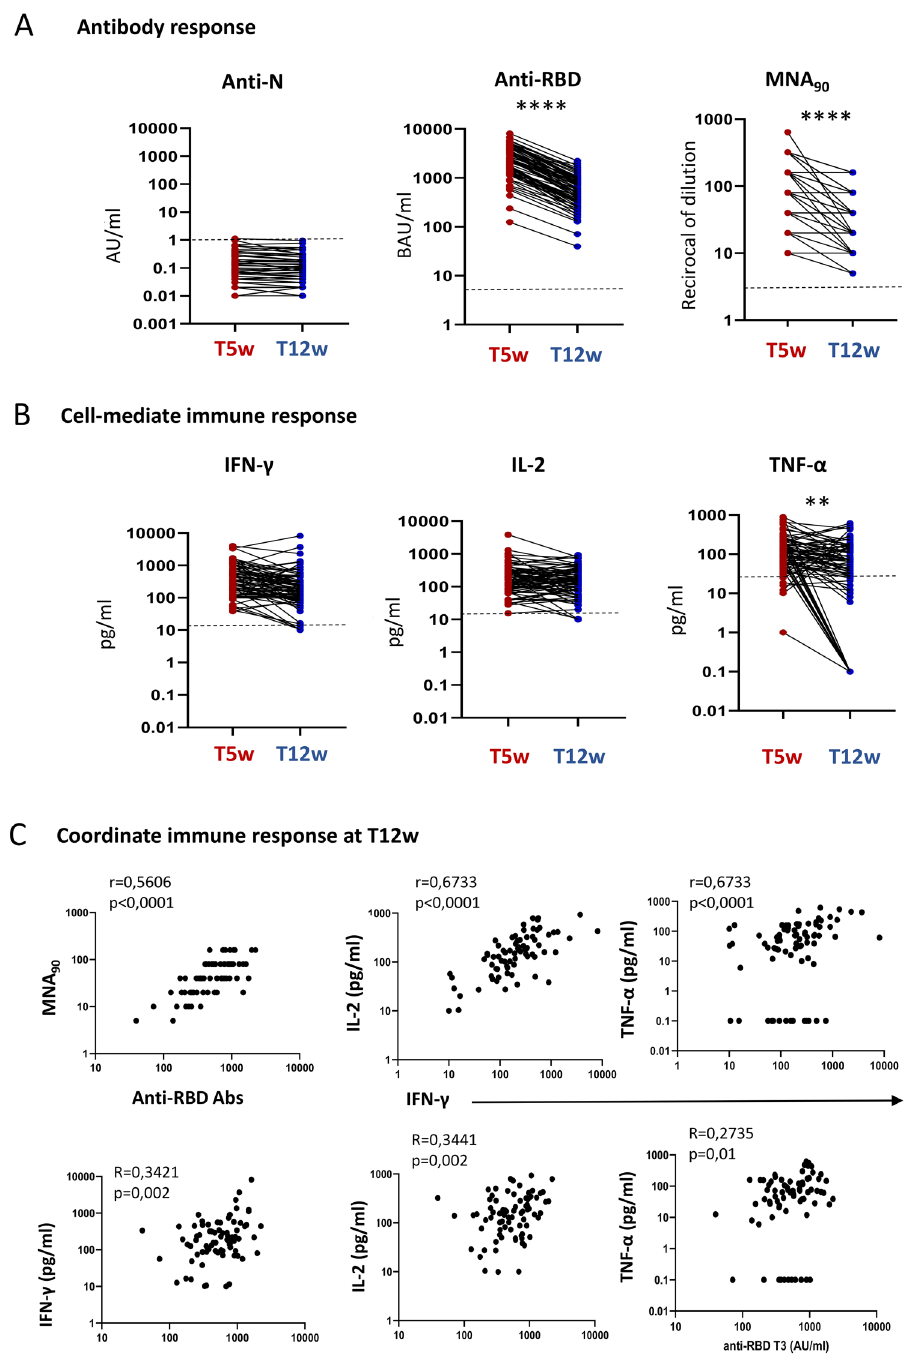
Figure 1. ( A ) Humoral response 5 (T5w) and 12 (T12w) weeks after vaccination. SARS-CoV-2 specific anti-N, anti-RBD and neutralizing Abs were quantified in sera samples at both time points. Anti-N-IgG are expressed as index values S/CO and values ≥ 1.4 are considered positive; Anti-RBD-IgG are expressed as Binding Arbitrary Units (BAU)/mL and values ≥ 7.1 are considered positive; neutralizing Abs are expressed as the highest serum reciprocal of dilution inhibiting at least 90% of the cytopathic effect (MNA 90 ), values ≥ 10 are considered positive. ( B ) Cell-mediated immune response 5 (T5w) and 12 (T12w) weeks after vaccination. Cytokines (IFN-γ, TNF-α, IL-2) were quantified in stimulated blood samples at both time points and showed after subtracting the background. Dashed line identify the cut-off of each test calculated as the mean ± 2SEM of 55 anti-S and anti-N negative HCW before vaccination. Differences between the median in T5w and T12w were calculated by paired t test. ****p < 0.0001; *p < 0.5. ( C ) Correlation between humoral and cell-mediated immune response 12 (T12w) weeks after vaccination. Correlations within humoral levels (anti-RBD and MNA 90 ), within cell-mediated response (IFN-γ, TNF-α and IL-2) and across humoral and cell-mediated immunity (anti-RBD and IFN-γ, TNF-α and IL-2) are shown. Correlation was analyzed by Spearmen test. Comparison of medians across groups were evaluated by Wilcoxon test for pairwise comparisons. Correlations between assays were assessed by non-parametric Spearman’s rank tests. A 2-sided P value < 0.05 was considered statistically